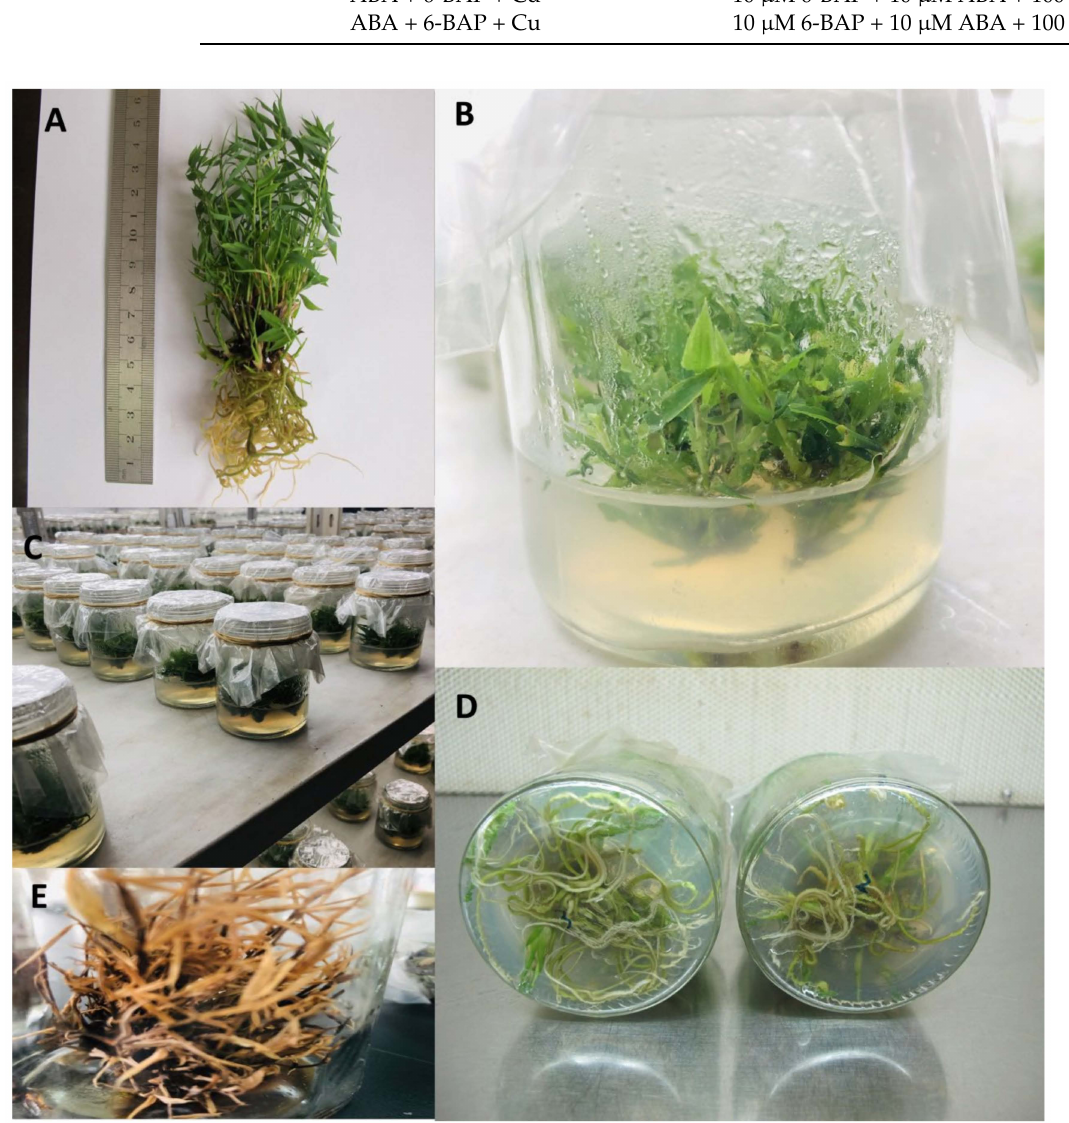
Figure 1. Bamboo plant phenotypes in vitro condition. ( A ) Bamboo height in the experiment ( B ) Bamboo treatments in the glass petri dish with culture medium ( C ) Bamboo treatments in the controlled plant tissue culture chamber ( D ) Roots proliferated from the immature shoots in bamboo species ( Pleioblastus pygmaeus ), ( E ) Exposure of the bamboo plant to 100 µ M